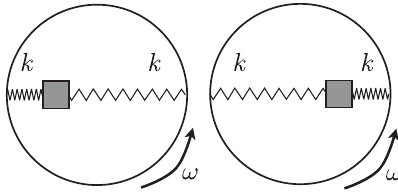
FIG. 1. Left: the initial diagram. A block is attached to two springs and displaced to the left. Each spring has spring constant (stiffness) k , and the circular rotating platform spins in the plane of the page at angular speed ω . Right: Zeke ’ s revised diagram, in which he moves the block to the right of